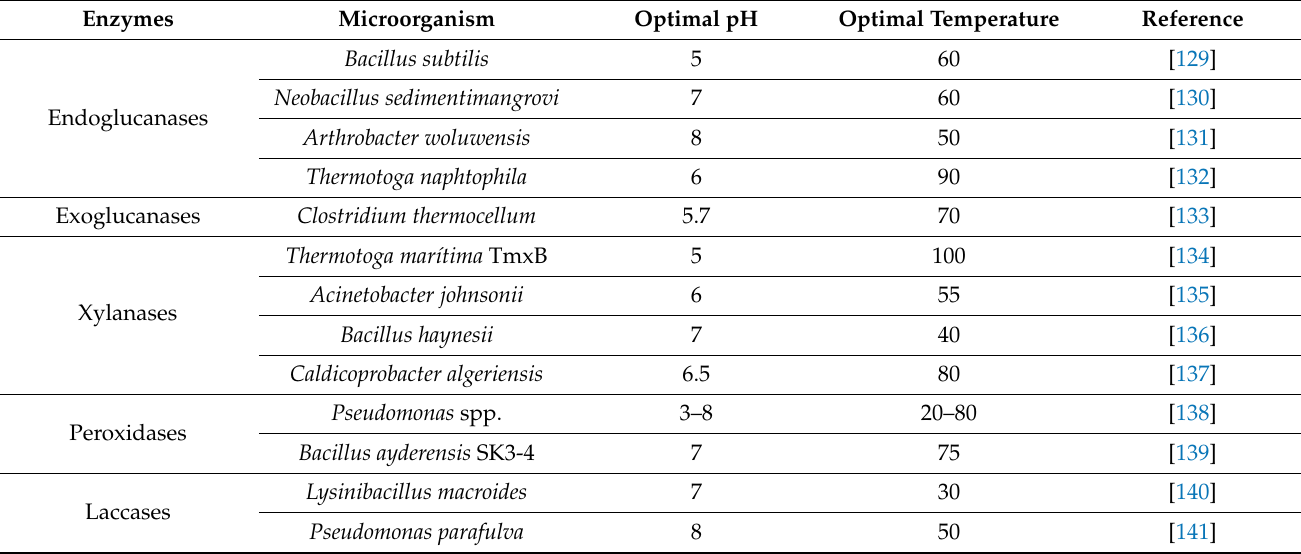
Table 1. Examples of bacteria producing lignocellulolytic